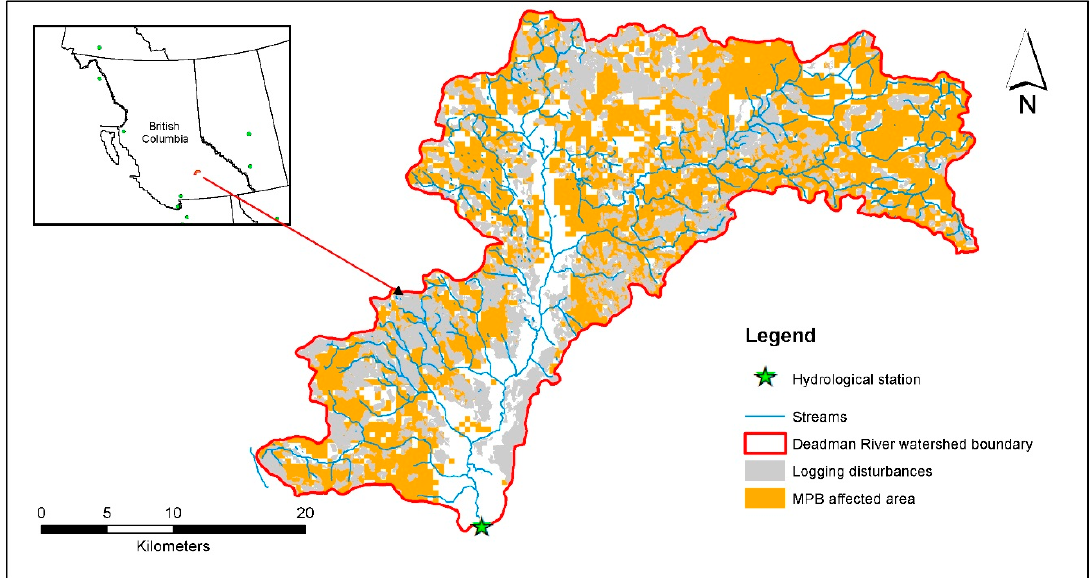
Figure 1. The location of watershed boundary, hydrometric station, stream network, forest logging, and mountain pine beetle (MPB) infestation of the Deadman River watershed, located in British Columbia,